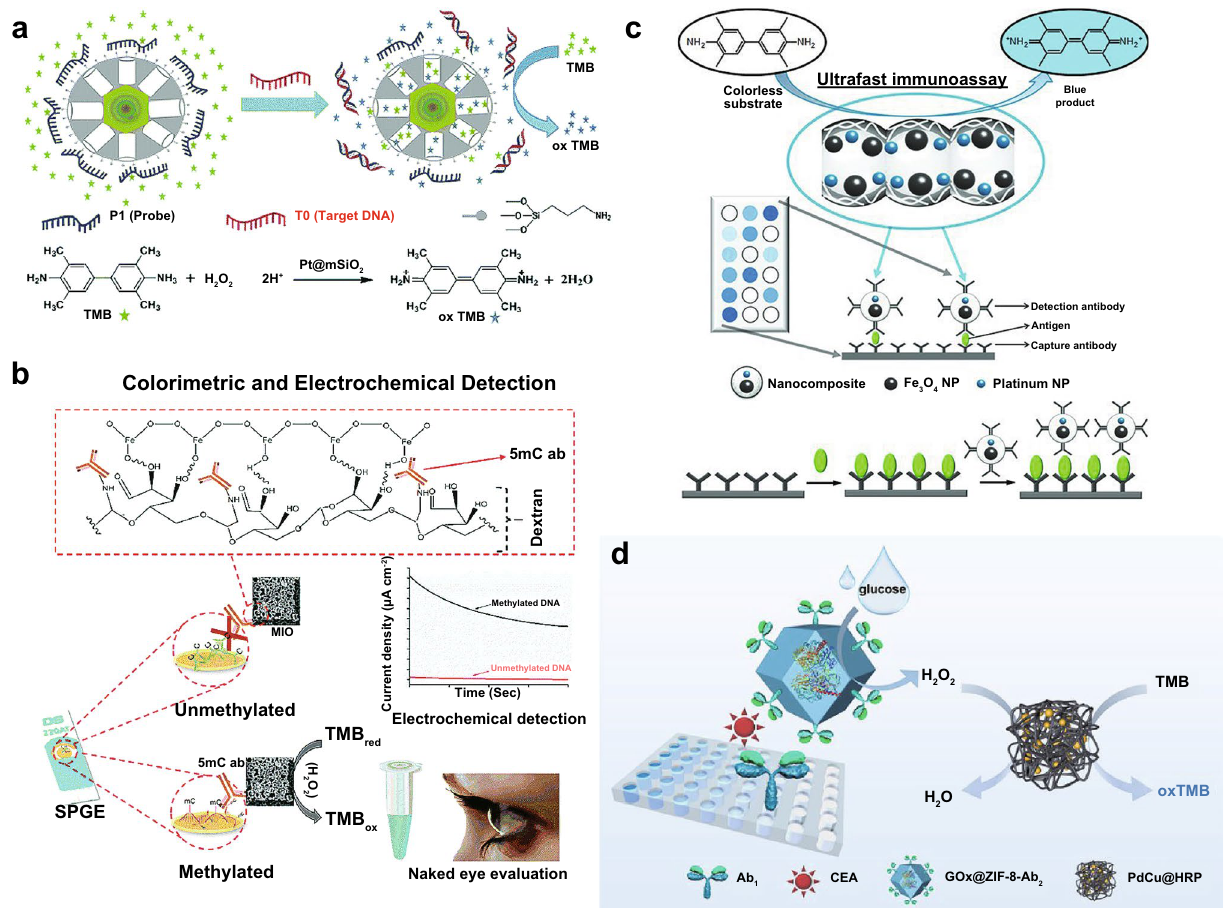
Fig. 7 a Scheme illustrating the mechanism of POD-like Pt@mSiO 2 for DNA detection. Reproduced with permission from Ref. [107]. Copy- right 2014, The Royal Society of Chemistry. b Schematic representation for the detection of global DNA methylation using 5mc-MIO. Repro- duced with permission from Ref. [108]. Copyright 2018, The Royal Society of Chemistry. c Colorimetric immunoassay for antigen (e. g., HER2) detection based on the antibody-conjugated nanocomposites with POD-like ability. Reproduced with permission from Ref. [33]. Copyright 2013, WILEY–VCH GmbH. d Schematic illustration for the catalytic cascade detection of CEA by PdCu@HRP. Reproduced with permission from Ref. [109]. Copyright 2021, American Chemical